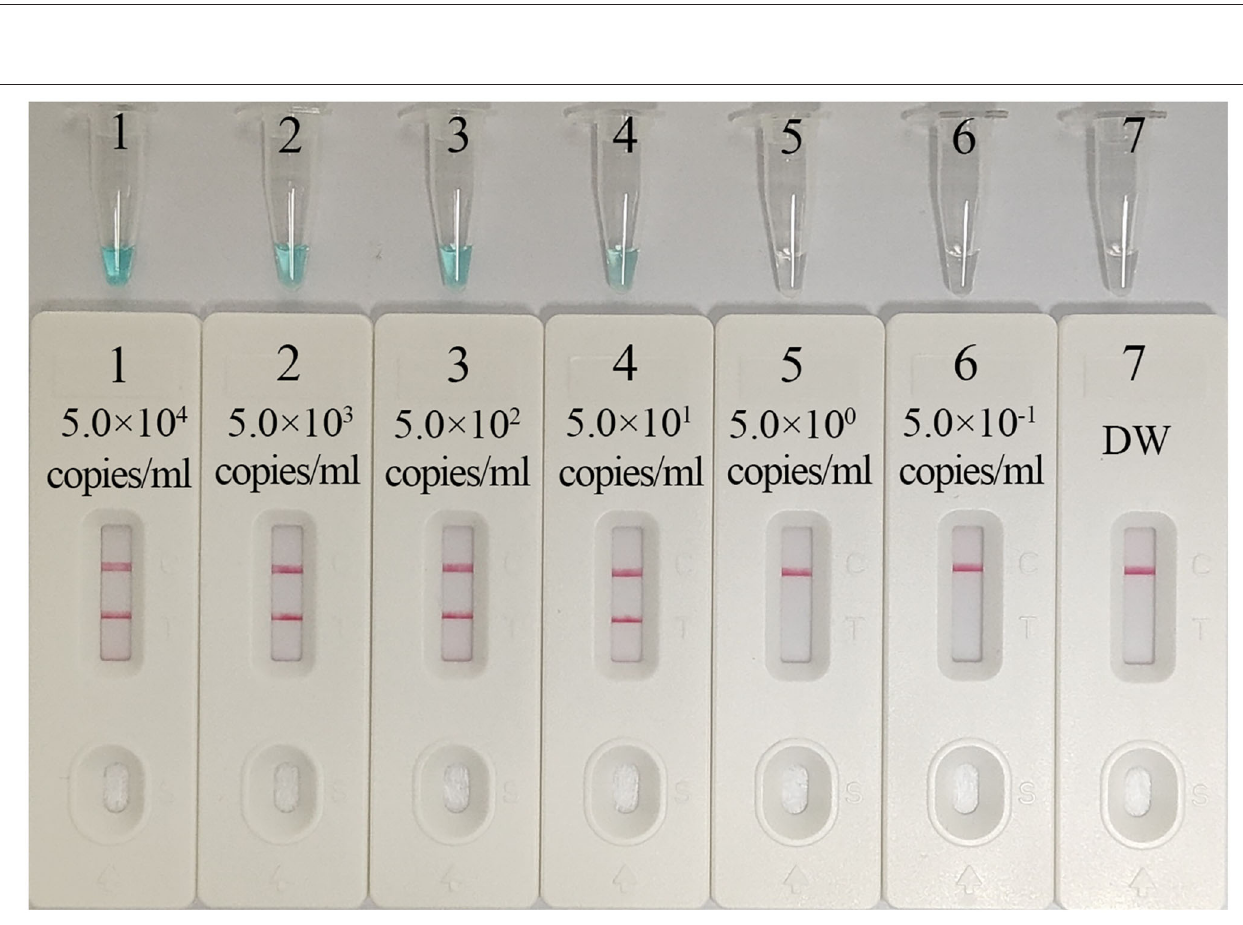
FIGURE 5 | Assay sensitivity using serially diluted C. trachomatis ompA -plasmid templates. (A) Visual MG regents used for detecting the results; (B) LFB used for detecting the results. Tubes A1–A7 (biosensors B1–B7) represent the C. trachomatis ompA -plasmid levels of 5.0 × 10 4 , 5.0 × 10 3 , 5.0 × 10 2 , 5.0 × 10 1 , 5.0 × 10 0 , 5.0 × 10 − 1 , and 5.0 × 10 − 2 copies/ml and blank control (distilled water). The template levels from 5.0 × 10 4 to 5.0 × 10 1 copies/ml showed positive results. CL, control line; TL, test